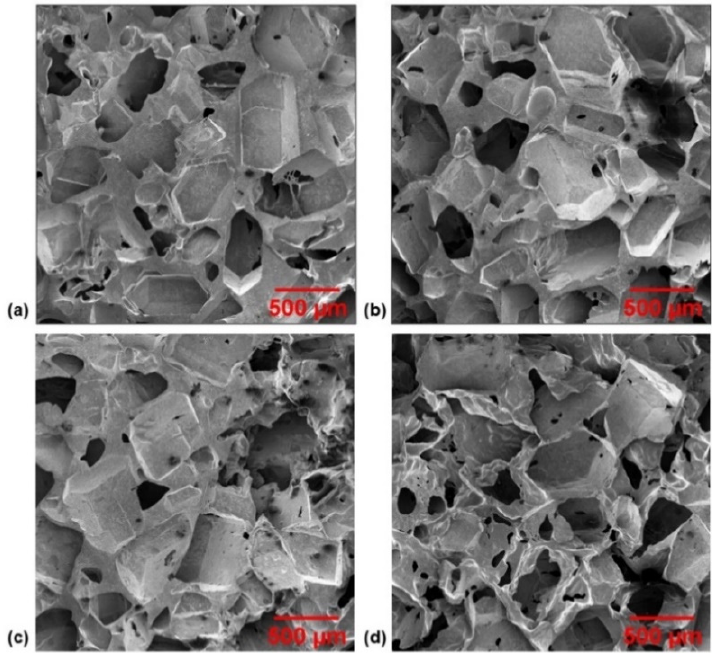
Figure 4. SEM images of the microstructure of various porosity sponges with 3 wt% CNT loadings and ( a ) 70 wt%, ( b ) 75 wt%, ( c ) 80 wt%, and ( d ) 85 wt% sugar porogen.